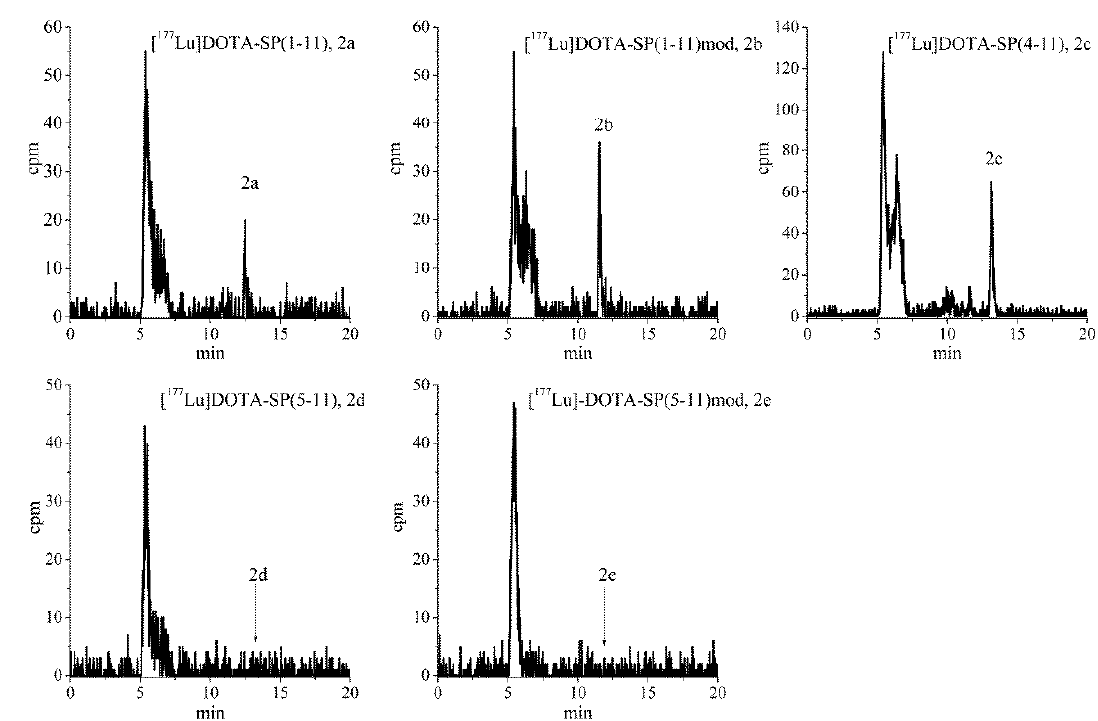
Figure 5. HPLC chromatograms of 2a–e radiobioconjugates after incubation in human serum at 37 ◦ C for 24 h.